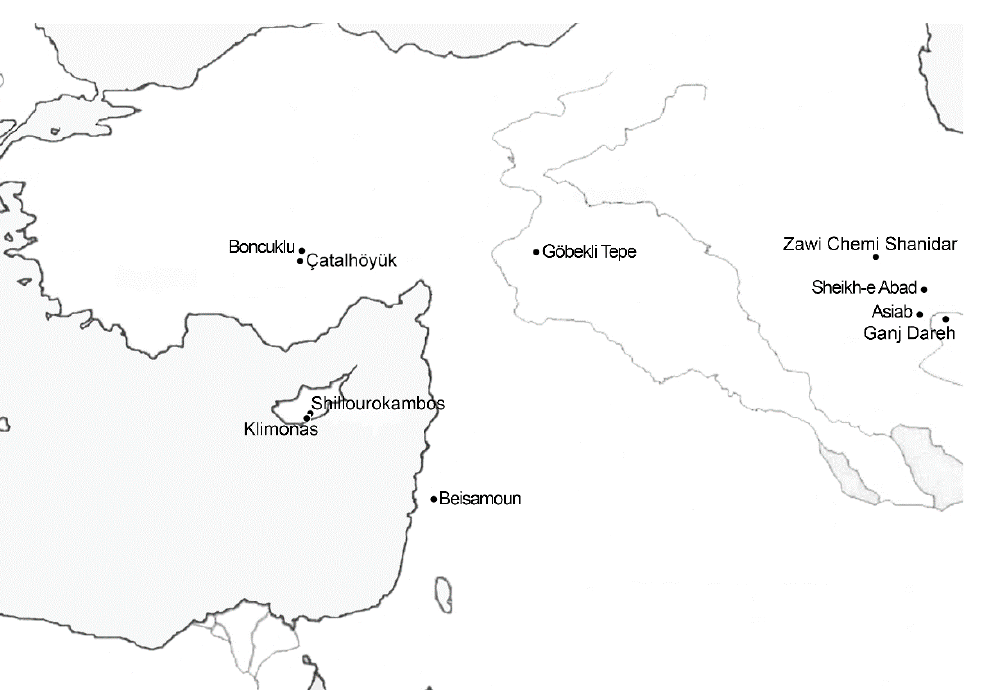
Figure 1. Near East with sites mentioned in the text.